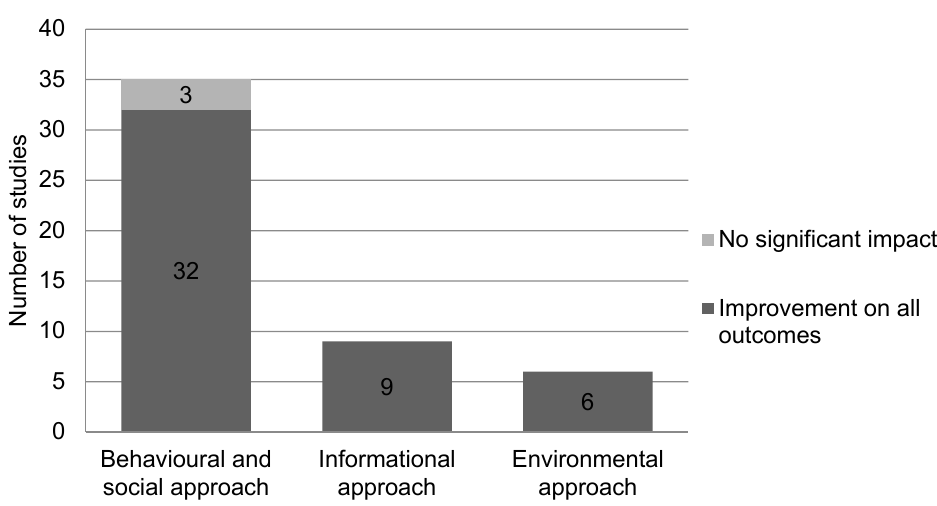
Figure 2. Impact of interventions on all outcomes.